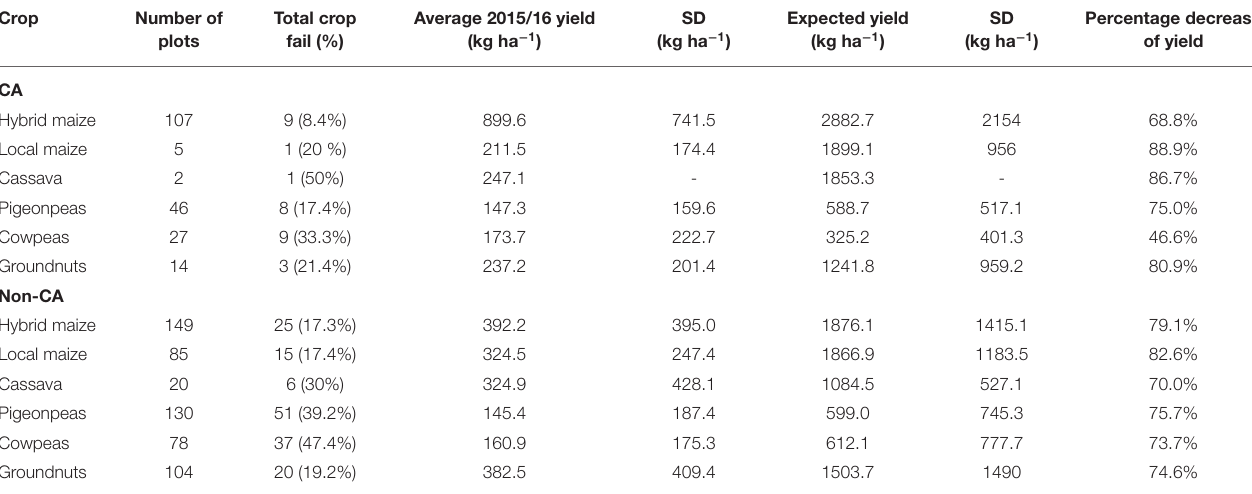
TABLE 5 | Crop yields under CA and non-CA in 2015/16 and the yields that are normally expected. Crop